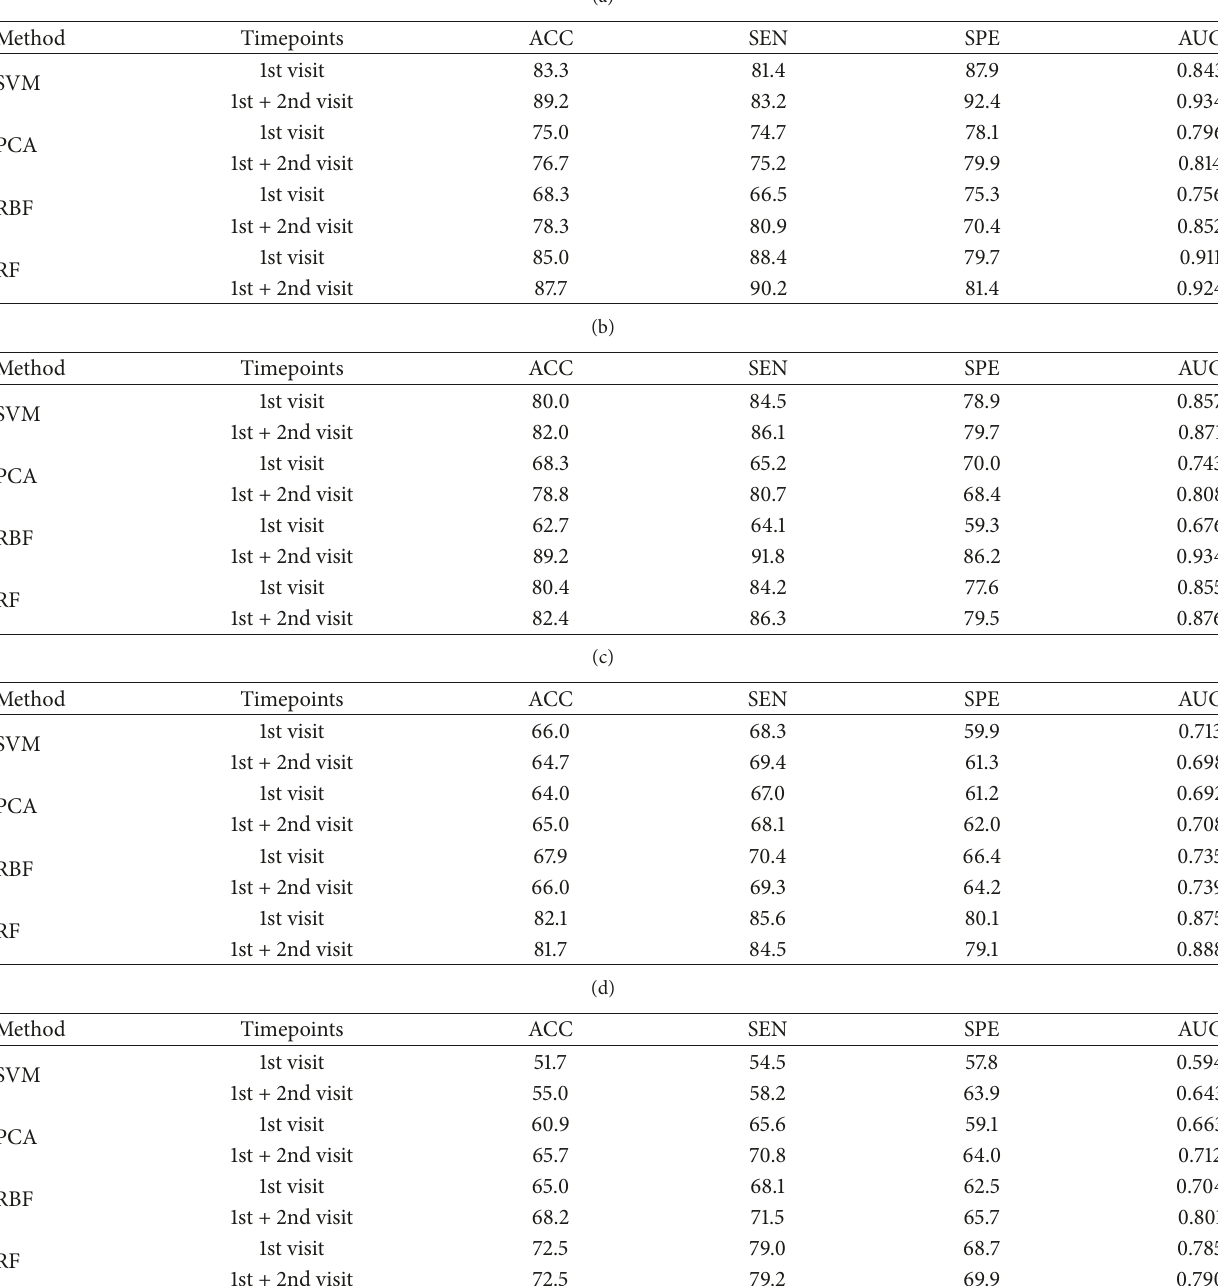
Table 4: Classification performance in whole-brain approaches (SVM, PCA, RBF, and RF), evaluating accuracy (ACC), sensitivity (SEN), specificity (SPE), and area under the curve (AUC). (a) AD versus NC; (b) AD versus EMCI; (c) AD versus LMCI; (d) EMCI versus